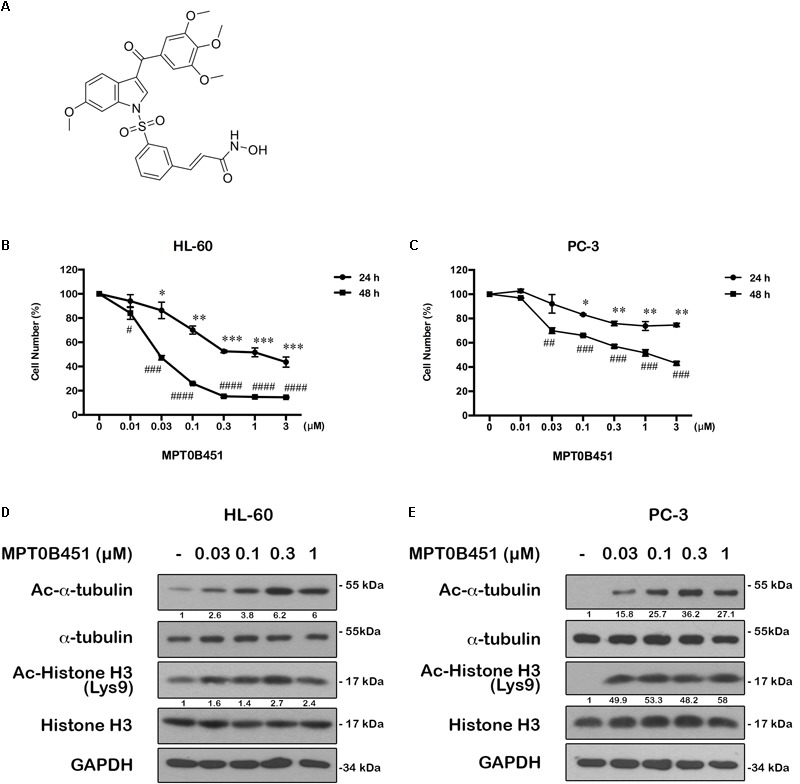
The structure of MPT0B451 and its potential anticancer effect in cancer cell lines. (A) Structure of 1-benzylindole derivative compound, MPT0B451. The human cancer cell lines HL-60 (B) and PC-3 (C) were treated with various concentrations of MPT0B451 for 24 and 48 h, and cell viability was measured by MTT assay. The results represent the mean ± SD of three independent experiments at ∗p < 0.05, ∗∗p < 0.01 and ∗∗∗p < 0.001compared with 24 h control group; #p < 0.05, ##p < 0.01, ###p < 0.001 and ####p < 0.0001 compared with 48 h control group. (D,E) The effect of α-tubulin and histone H3 acetylation changes in HL-60 and PC-3 cells. Cells were culture with the indicated concentrations of MPT0B451 for 12 h then total cell lysates were detected by western blot analysis. The data were repeated at least three independent experiments.